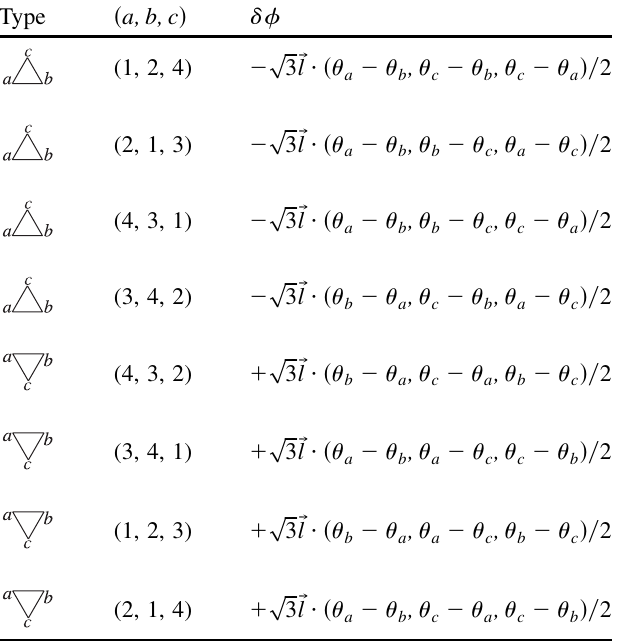
TABLE III. Asymptotic additional fluxes in triangular pla- quettes due to the presence of a